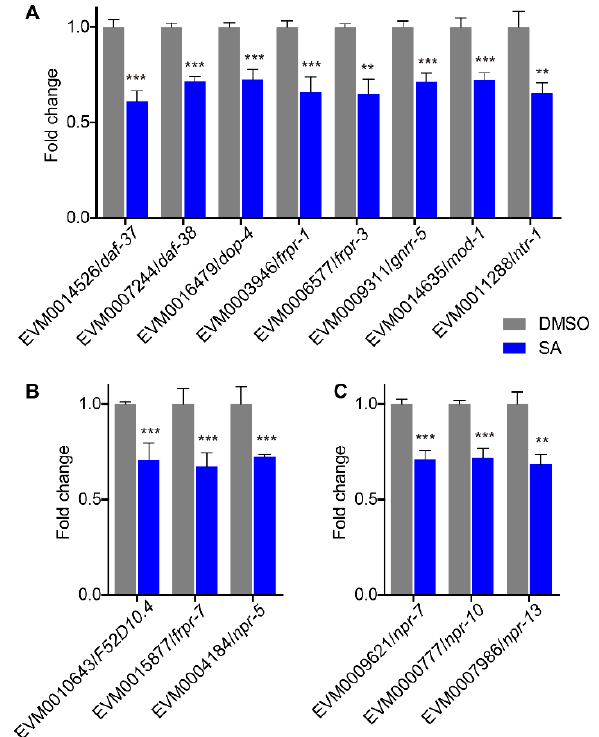
Figure 6. Downregulated expression of neuronal signaling related genes. ( A ) Expression level of “neuroactive ligand-receptor interaction” downregulated genes. ( B ) Expression level of “G-protein coupled receptor activity” genes. The expression level of downregulated genes EVM0007244/ daf-38 , EVM0016479/ dop-4 , EVM0003946/ frpr-1 , EVM0006577/ frpr-3 , EVM0009311/ gnrr-5 , EVM0014635/ mod-1 , and EVM0011288/ ntr-1 enriched in this term is presented in ( A ). ( C ) Expression level of “neuropeptide Y receptor activity” genes. SA (stearic acid). The error bars represent SEM of the mean. ** p adj < 0.01, *** p adj <